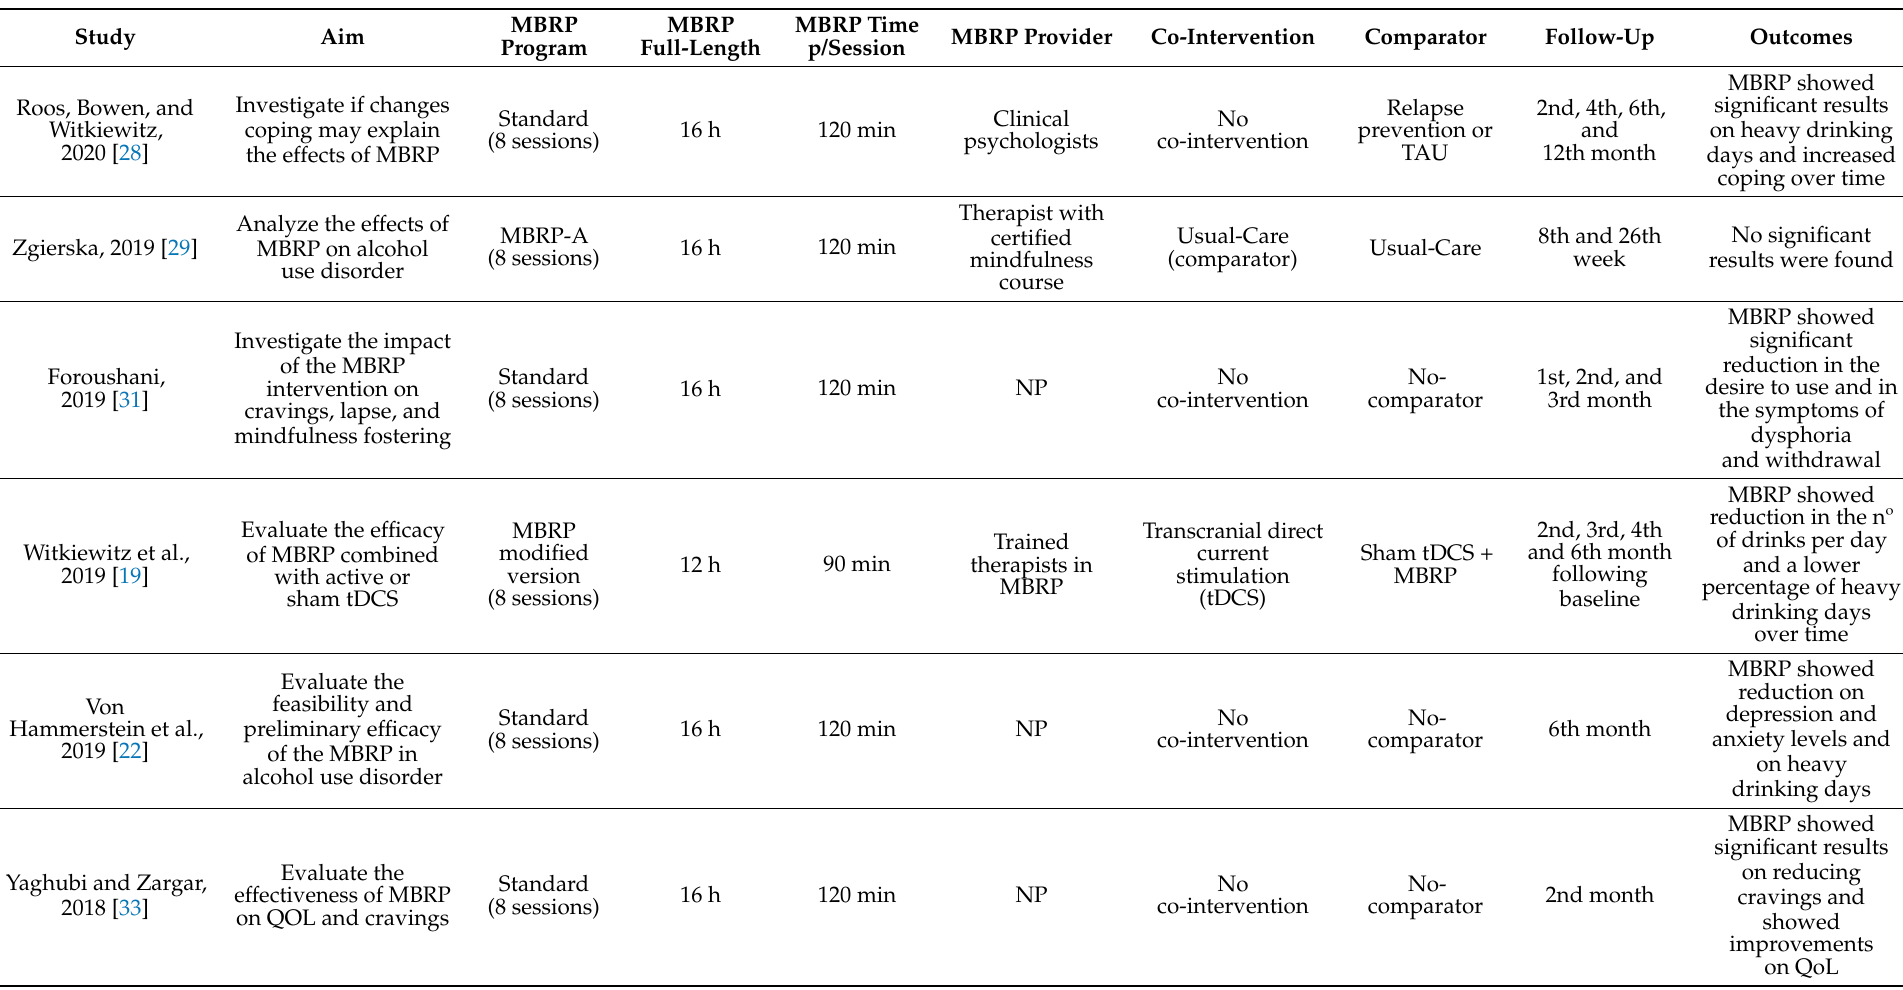
Table A6. Summary of included